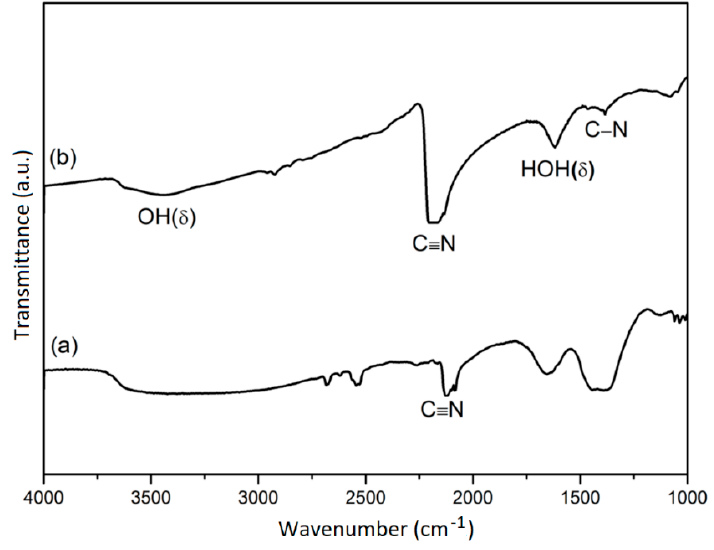
Figure 2. FTIR spectra of ( a ) K 2 Ni(CN) 4 ·H 2 O and ( b ) Cu-Ni_0.20.